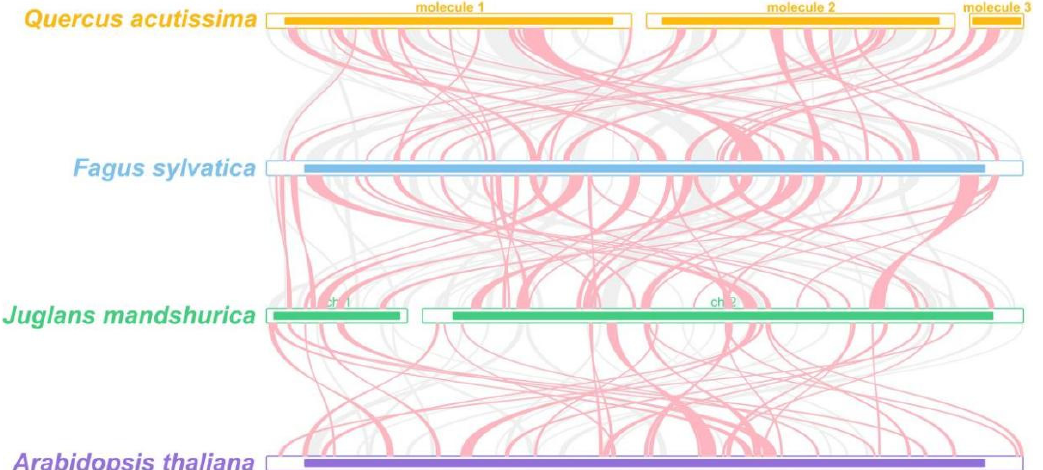
Figure 9. Mitogenome synteny. Bars indicated the mitogenomes, and the ribbons showed the homologous sequences between the adjacent species. The red areas indicate where the inversion occurred, the gray areas indicate regions of good homology. Common blocks less than 0.5 kb in length are not retained, and regions that fail to have a common block indicate that they are unique to the species. A. thaliana was also compared.